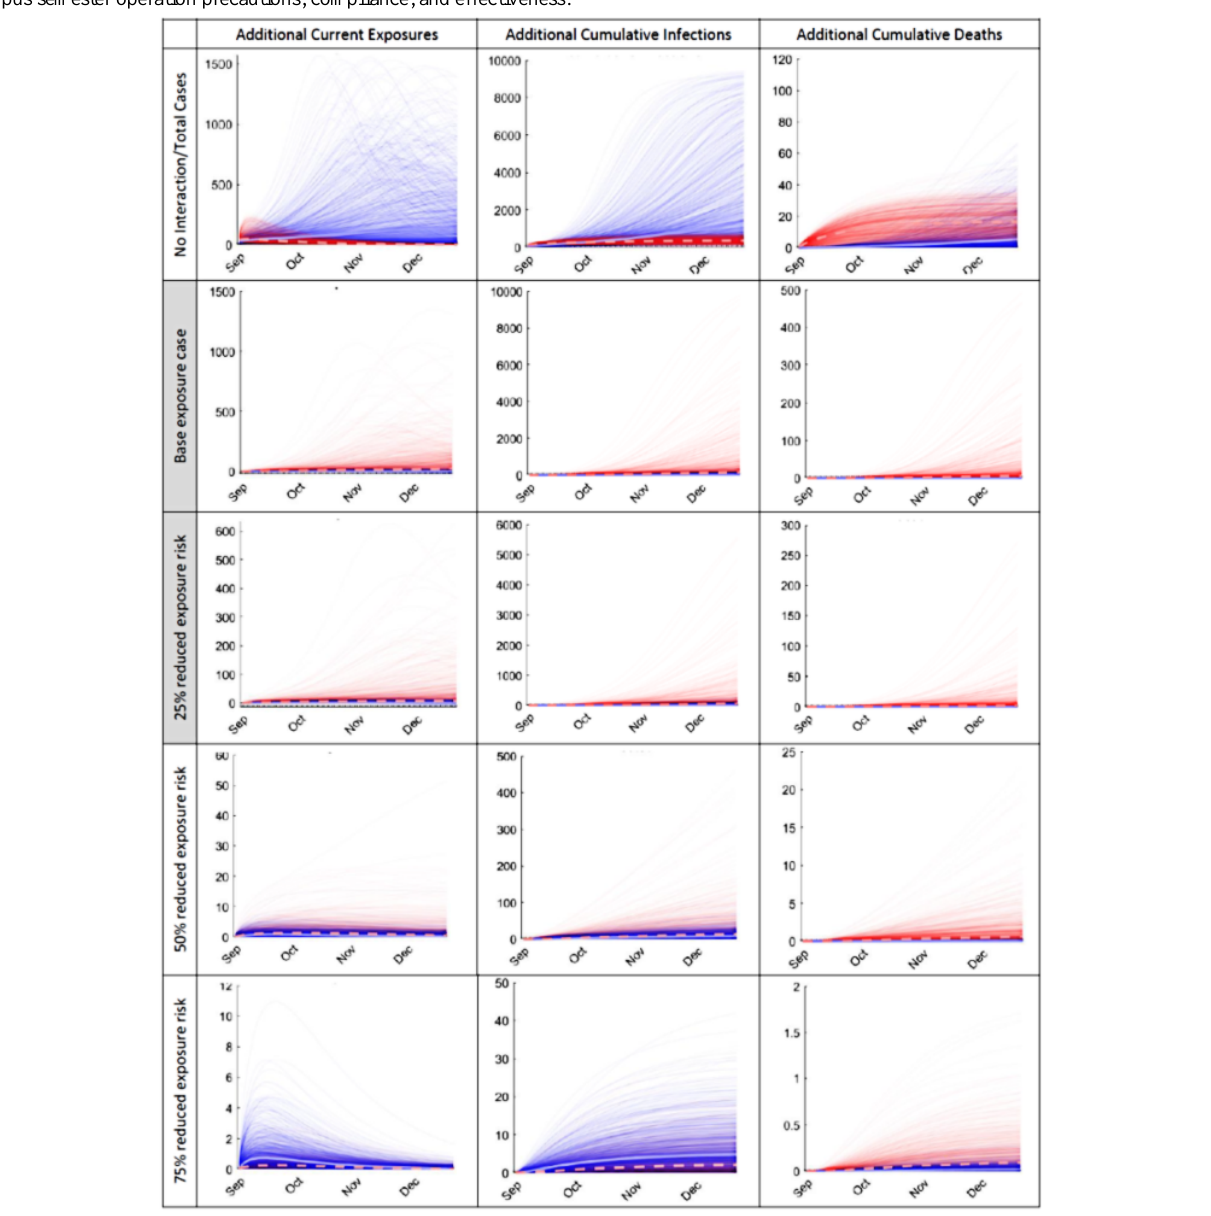
Figure 3. Additional (red) community and (blue) college campus COVID-19 exposures, infections, and mortality due to community × campus cross-exposure (fall 2020 semester, prevalence among arriving students varied between 0.1%-2%, urban university example). No interaction: total outcomes assuming no interaction between school and community. Base case: additional outcomes due to campus reopening assuming little-to-no campus semester operation precautions, compliance, or effectiveness. Shaded rows (most likely cases): additional outcomes assuming likely and ideal cases for campus operation precautions, adherence, and effectiveness. Bottom row: additional outcomes under a best case scenario assuming very high campus semester operation precautions, compliance, and